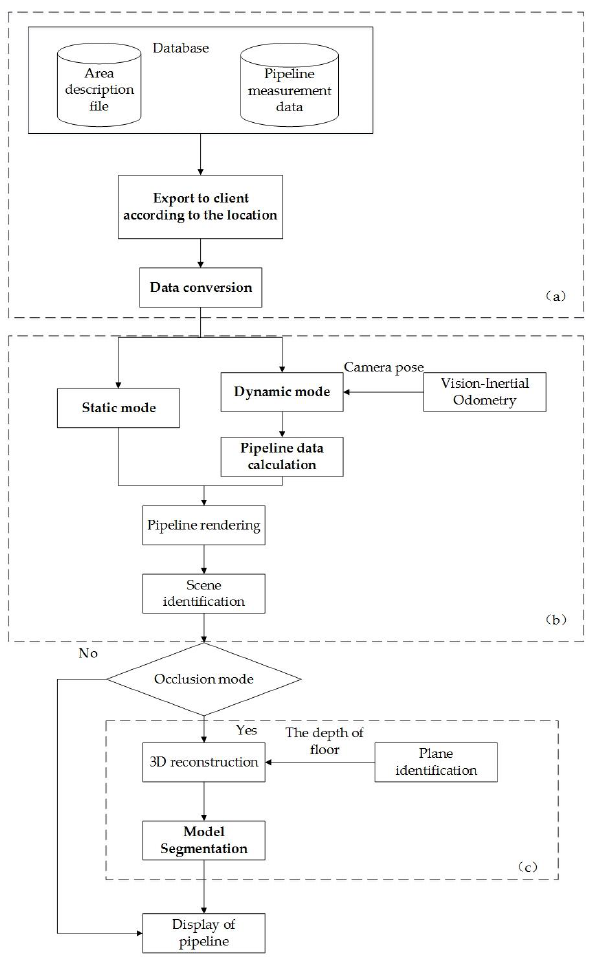
Figure 1. Architecture of the system with solutions for the three problems we proposed: (a) location- based data transmission, (b) tracking based on the Visual-Inertial Odometry (VIO), and (c) occlusion built by the 3D